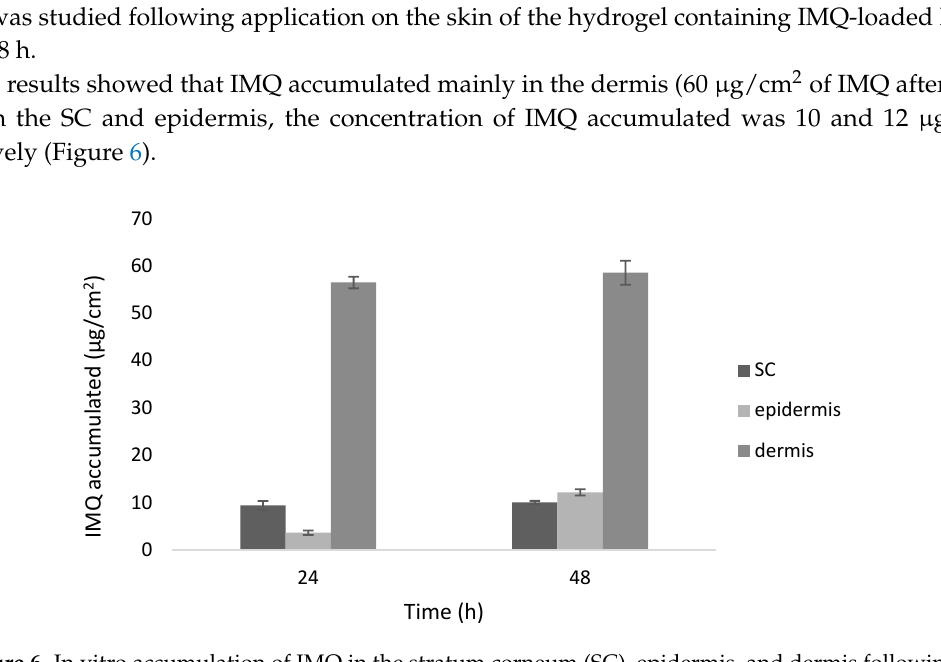
Figure 6. In vitro accumulation of IMQ in the stratum corneum (SC), epidermis, and dermis following application on the pig skin of a hydrogel containing IMQ-loaded NS for 24 and 48 h.